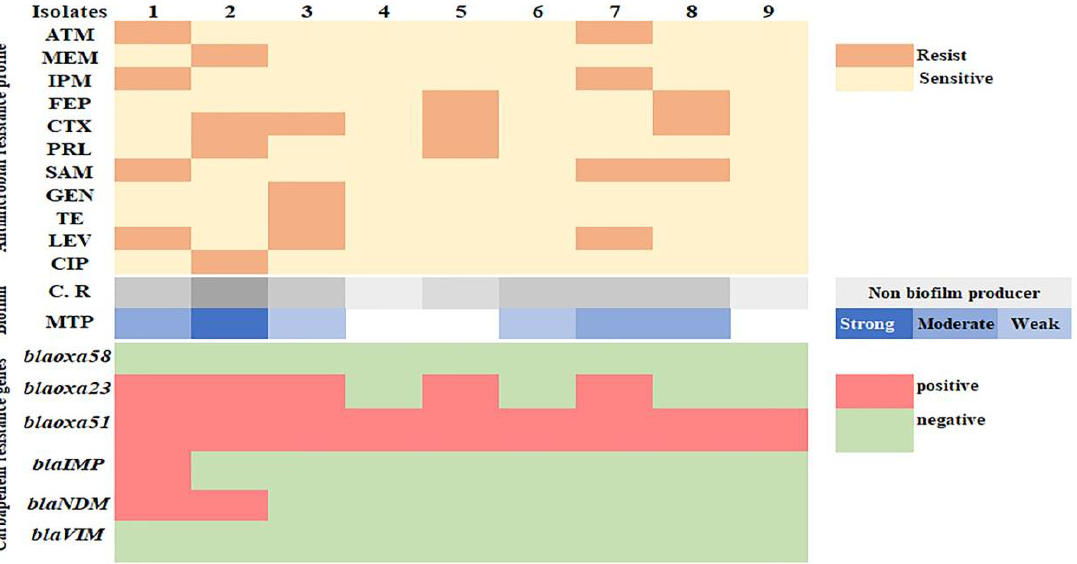
Figure 6. Heat map showing the antimicrobial resistance and biofilm formation ability of A. baumannii isolates.